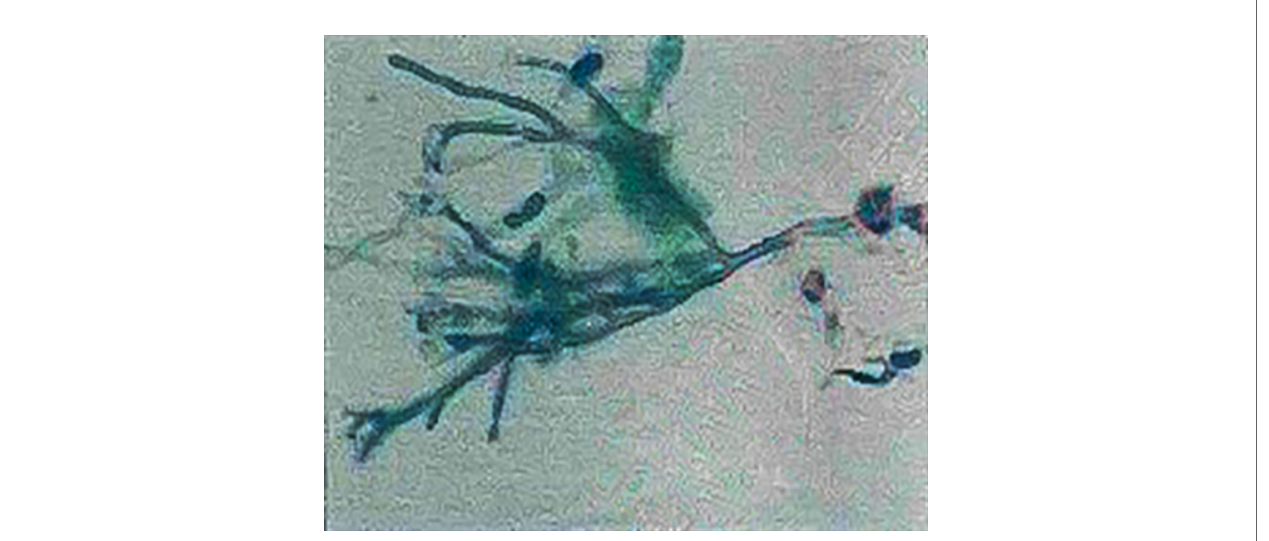
FIGURE 1 | Bronchoscopy liquid-based cytology showed